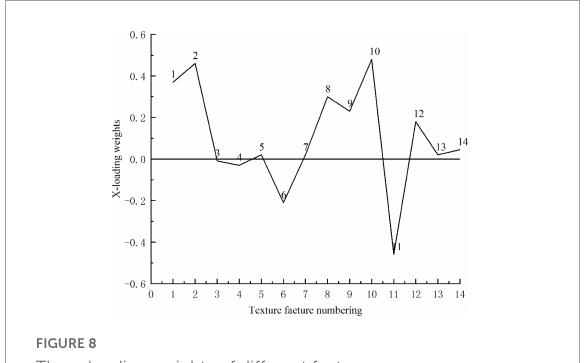
FIGURE8 The x -loading weights of different